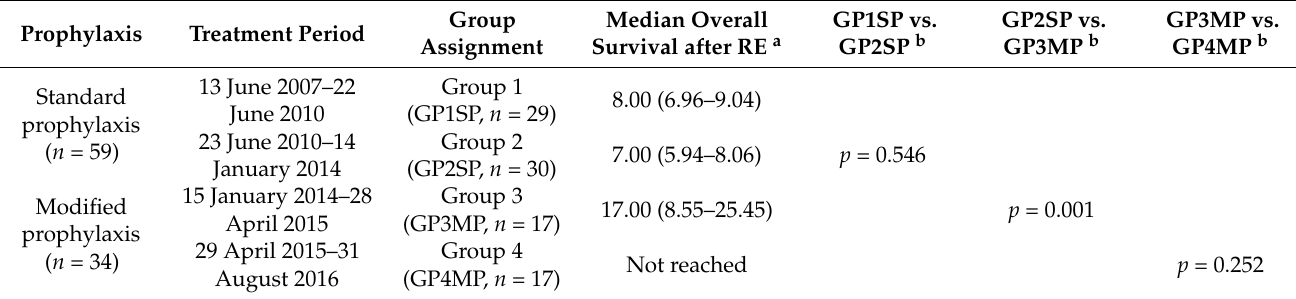
Table 5. Overall survival depending on time-point of